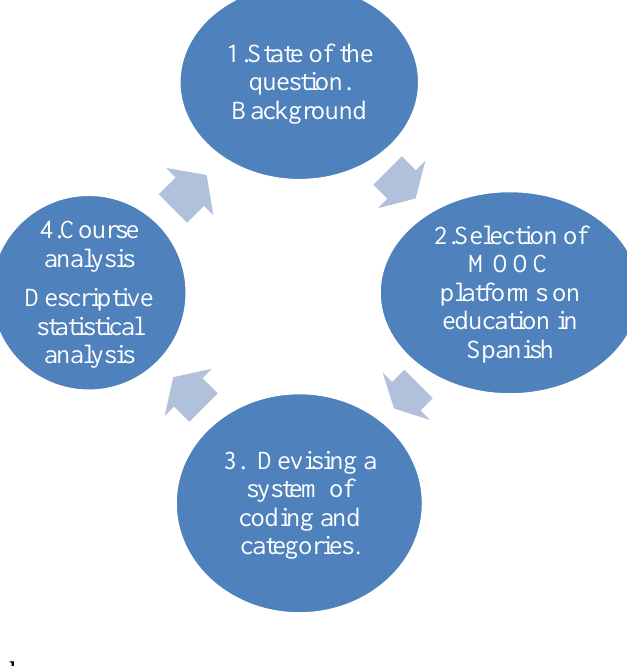
Figure 1. Research